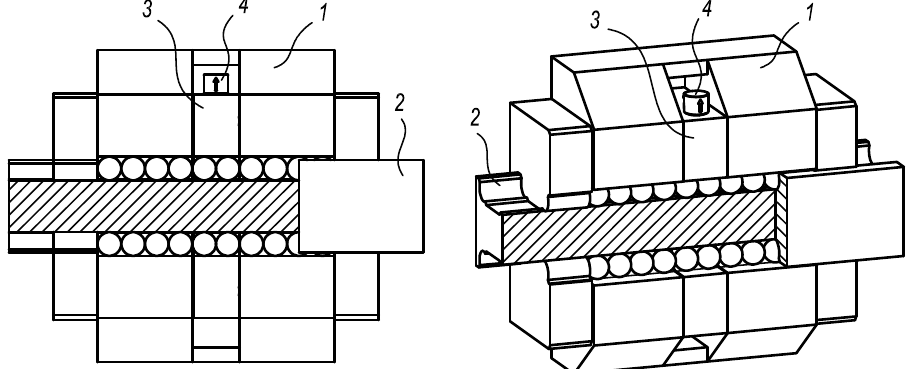
Figure 1. The linear rolling guide with the integrated diagnostic part: 1—carriage, 2—guiding profile, 3—diagnostic part, and 4—acceleration sensor.